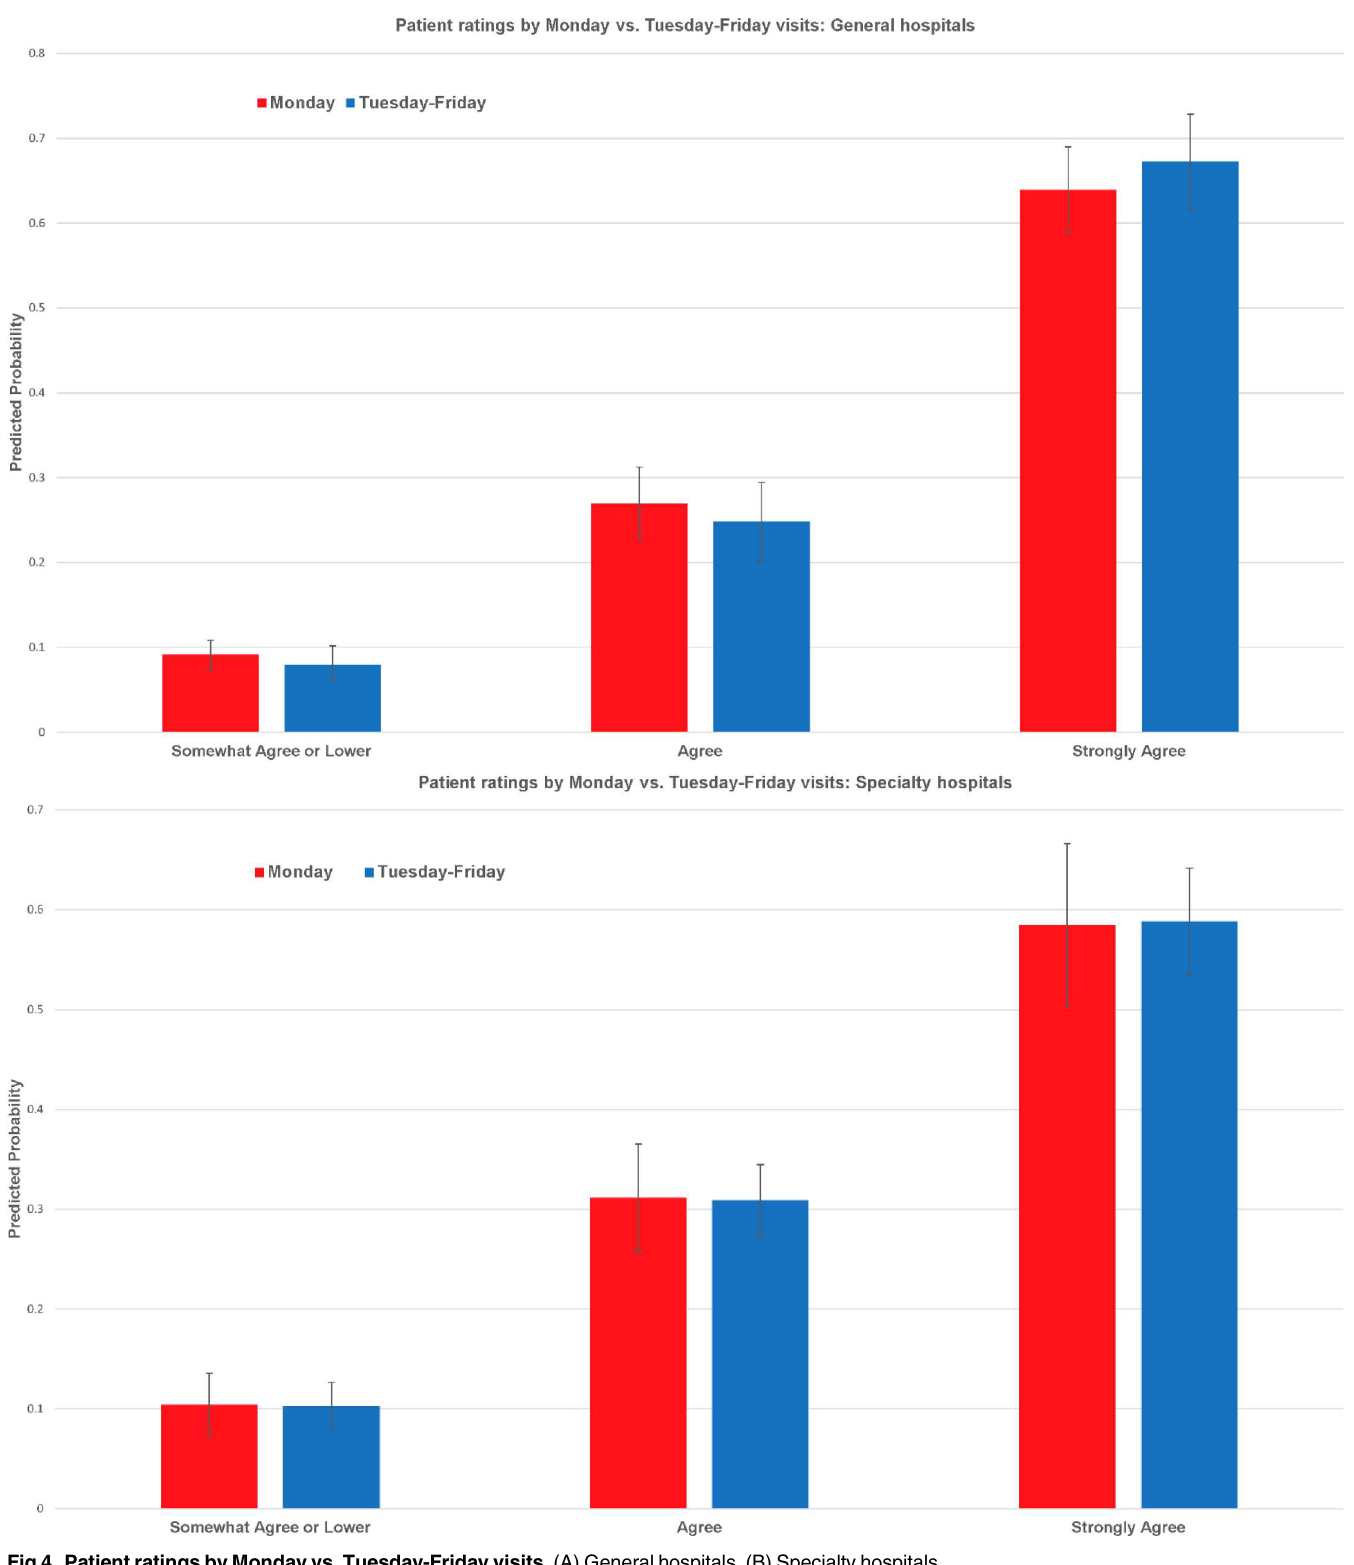
Fig 4. Patient ratings by Monday vs. Tuesday-Friday visits. (A) Generalhospitals.(B) Specialty hospitals.